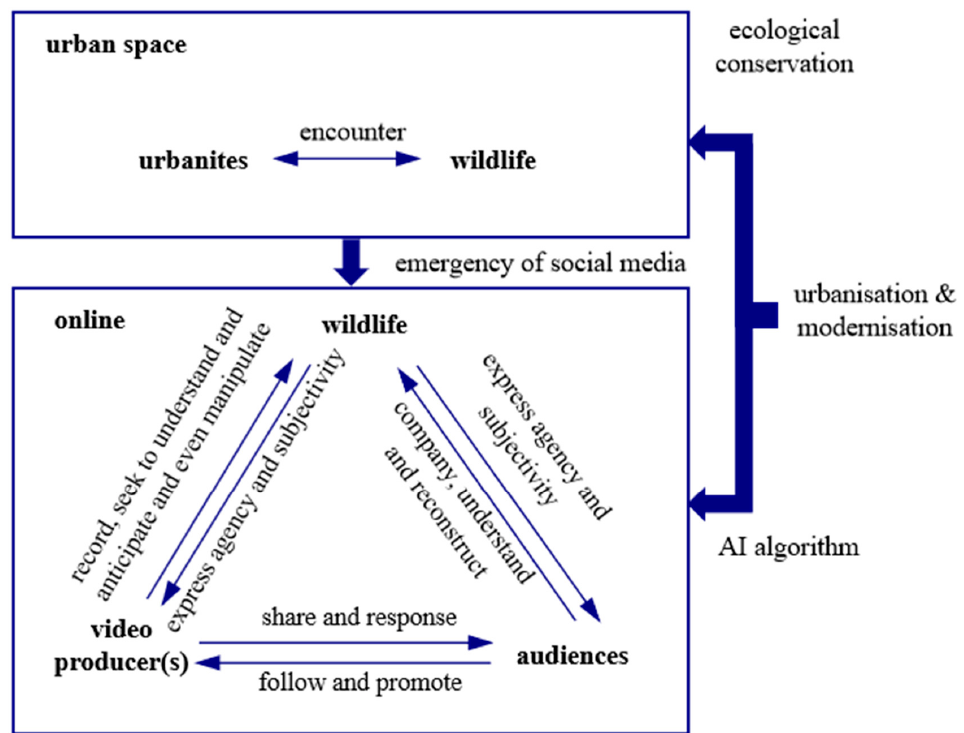
Figure 5. The general pa tt ern of human–urban wildlife relationship in social media.